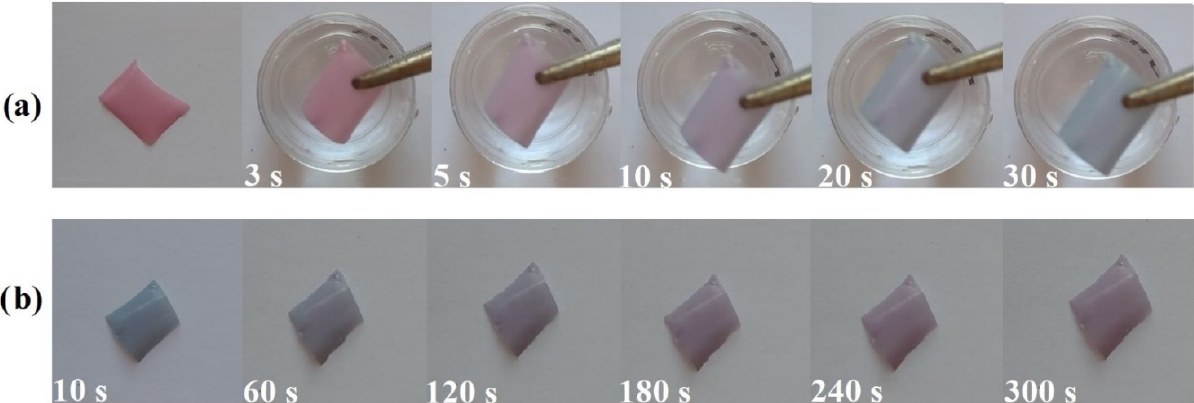
Figure 5. The colour changing performance of BCE-loaded PU nanofibrous mats after exposure ( a ) to ammonia vapour and subsequent removal ( b ).